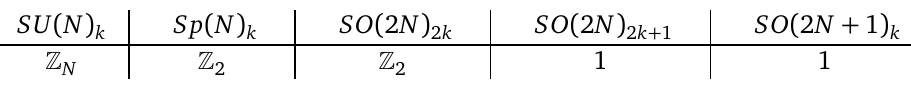
Figure 3: The proposed phase diagram for k < h Two of them at large | m λ | are visible semiclassically and the middle phase at small | m | is purely quantum. The supersymmetric point m λ